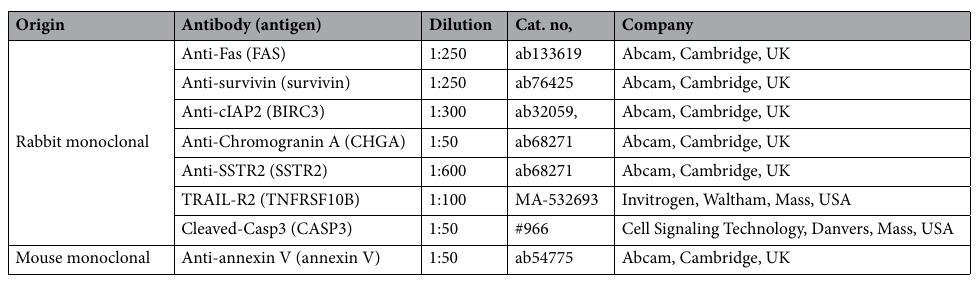
Table 1. Primary antibodies used for immunohistochemical staining of FFPE GOT1 tumor sections. The origin, name, dilution factor used, and manufacturers of the antibodies are listed.